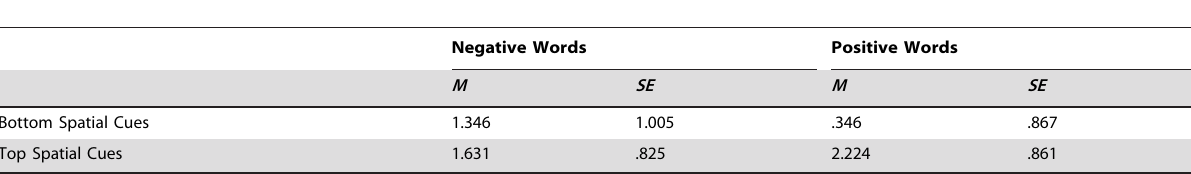
Table 3. Mean amplitudes ( m V) and standard errors ( SE ) in four different trial